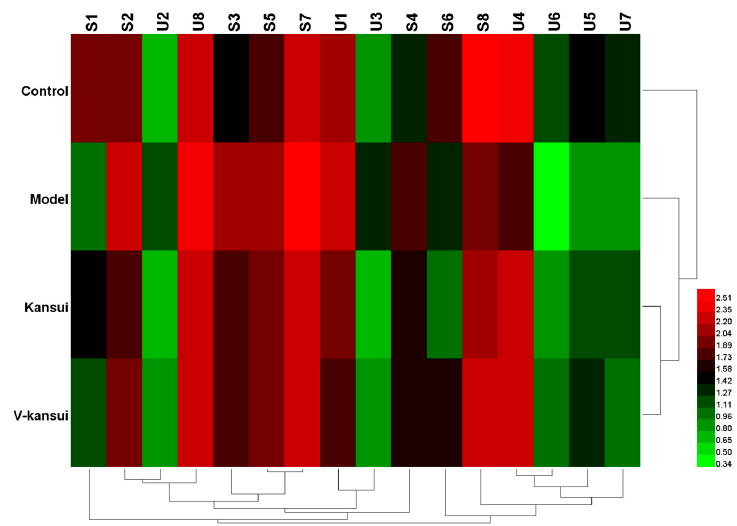
Figure 3. The heatmap of 16 potential metabolites.